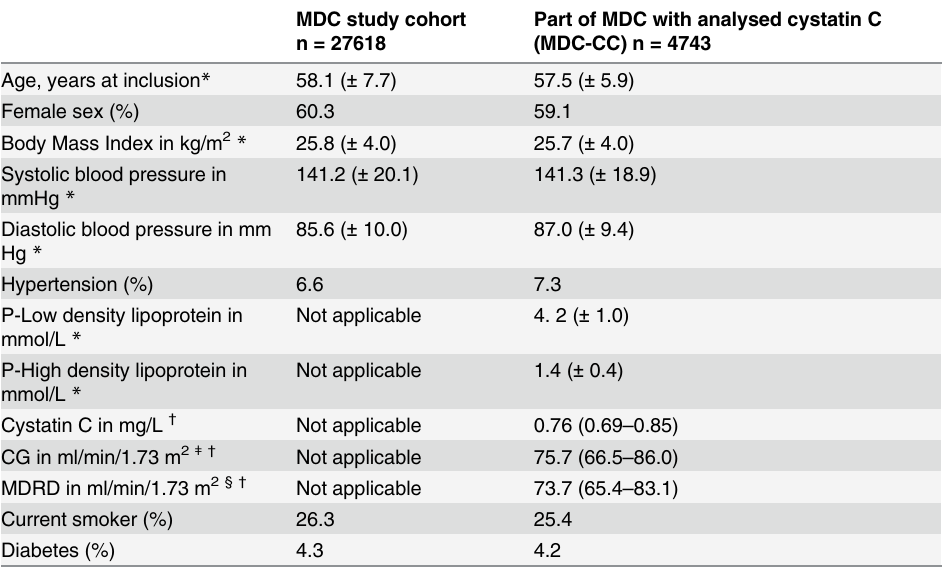
Table 1. Clinical characteristics given for all subjects and for the proportion that also had cystatin C